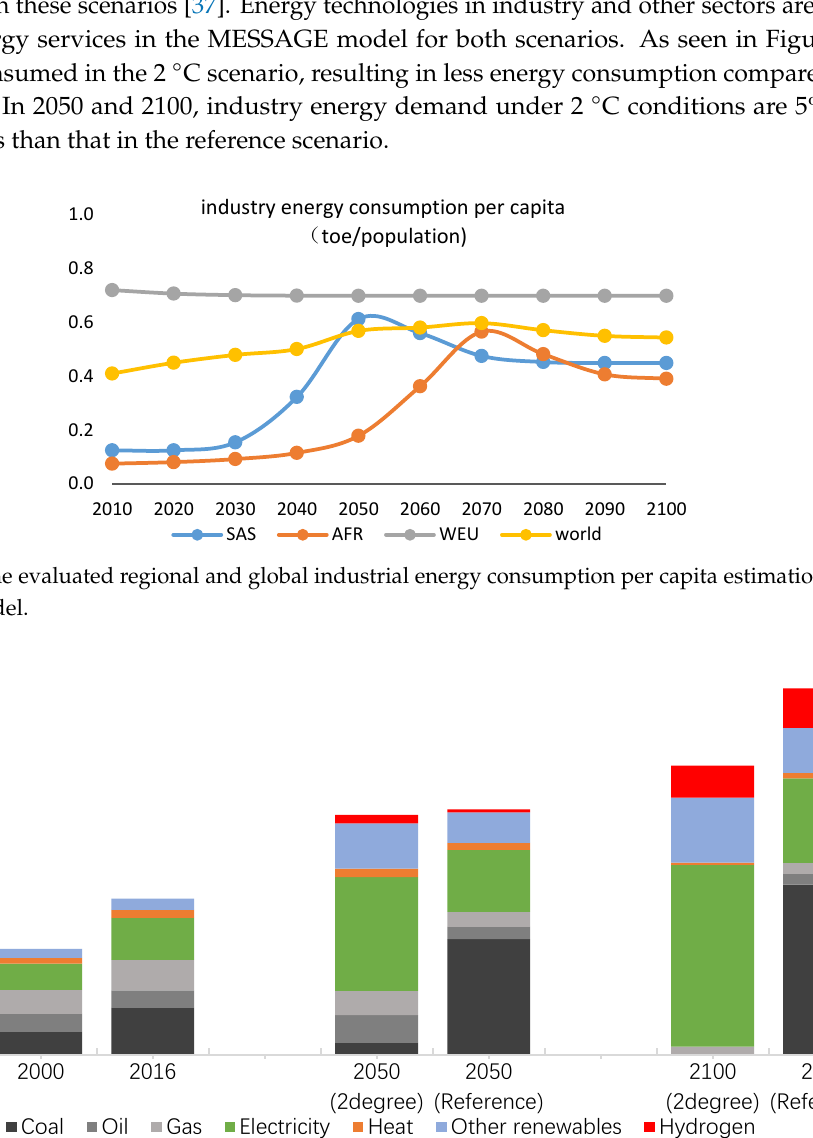
Figure 5. Industry energy demand and energy structure in 2050 and 2100 from 2 degree and reference scenarios.